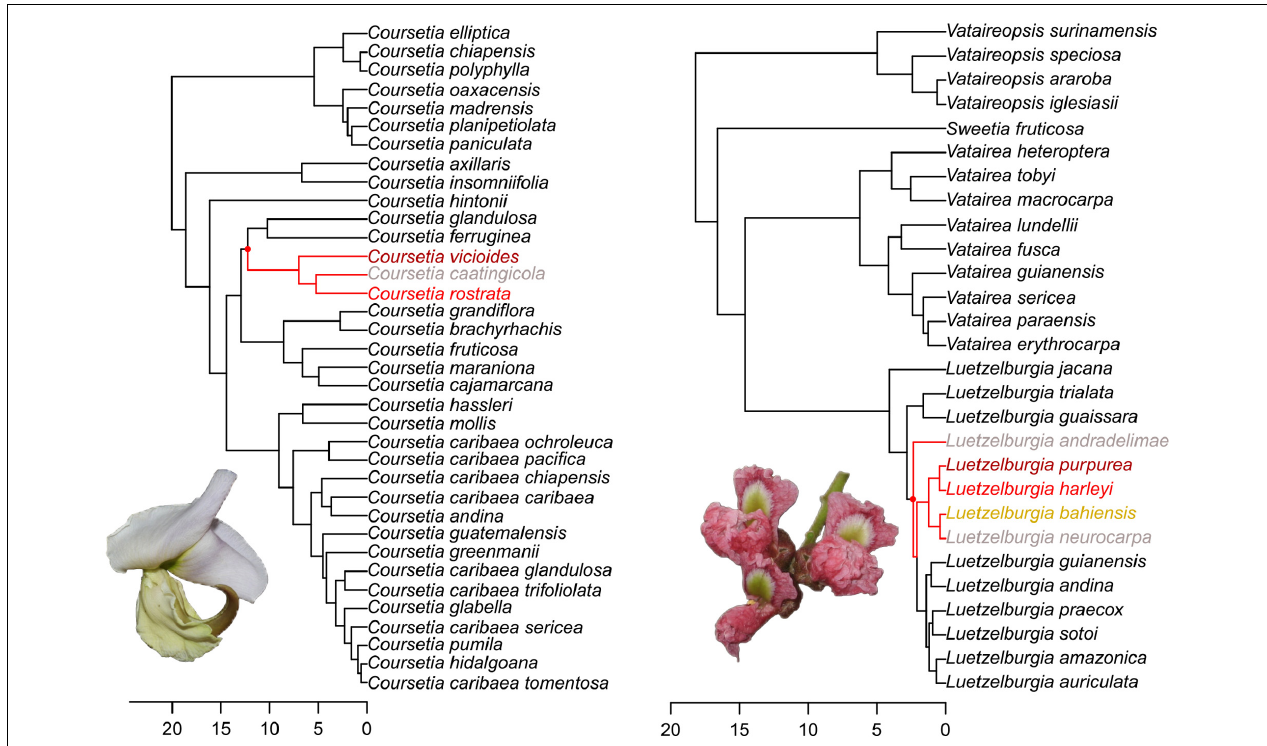
FIGURE 5 | BEAST-dated phylogenies showing examples of Caatinga endemic clades within the mostly SDTF endemic legume clades Coursetia (Queiroz and Lavin, 2011) and the Vataireoids (Cardoso et al., 2013; Cruz et al., 2018). Red dots indicate the nodes where isolation of lineages within the Caatinga occurs. Red lines indicate Caatinga endemic clades. Distinct name colors denote the type of geological substrate where the corresponding species is endemic: Arboreal Tall Caatinga (dark red); more open Crystalline Caatinga (light red); Sedimentary Caatinga (pale yellow); and Karst Caatinga (gray). Note that species do not group by geological substrate. Photos of Coursetia rostrata and Luetzelburgia neurocarpa by Domingos